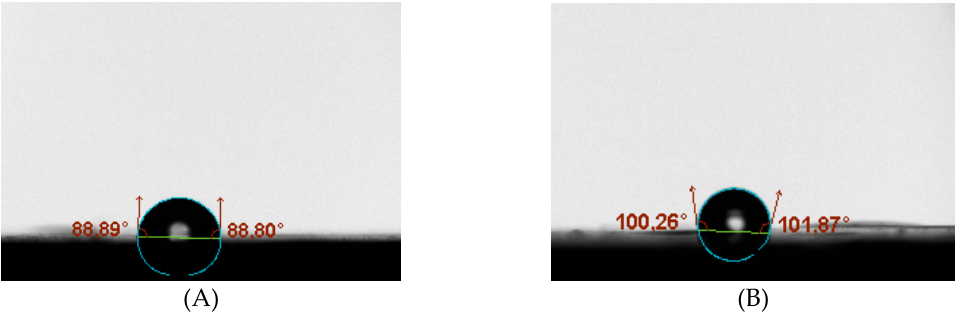
Figure 4. Contact angle measurement ( A ) Pure PTMSP membrane. ( B ) Hybrid membrane.